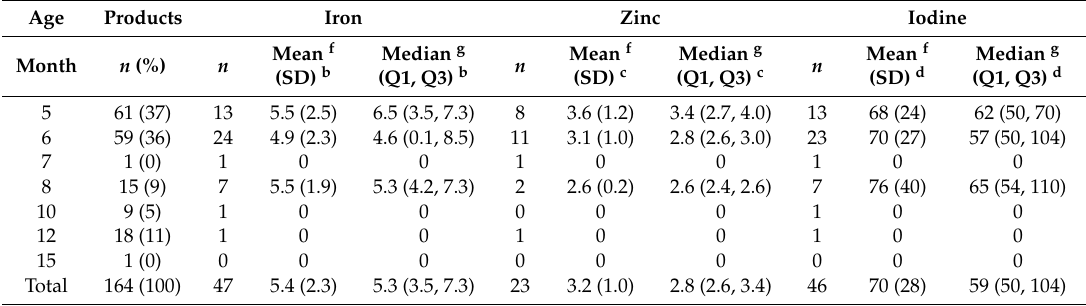
Table 1. Mean and median iron, zinc, and iodine contents of commercial complementary cereals as reported on food labels a